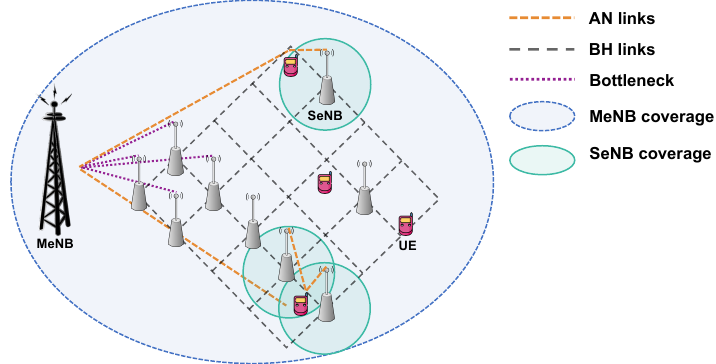
Figure 3. Experimental HetNet